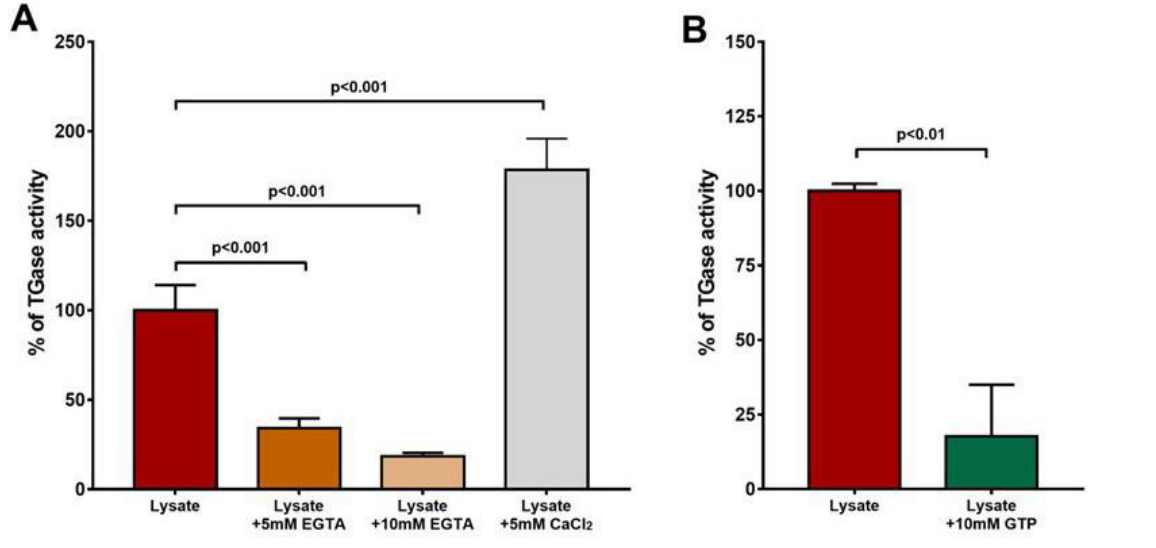
Figure 2. Ca 2+ activation and GTP inhibition of L. infantum promastigotes’ activity. The percentages of the activities are represented. ( A ) Addition of EGTA to the reaction mix significantly reduced the enzyme’s activity ( p < 0.001), and treatment of lysate with additional Ca 2+ increased the enzyme’s activity. ( B ) Addition of GTP markedly reduced TGase activity.